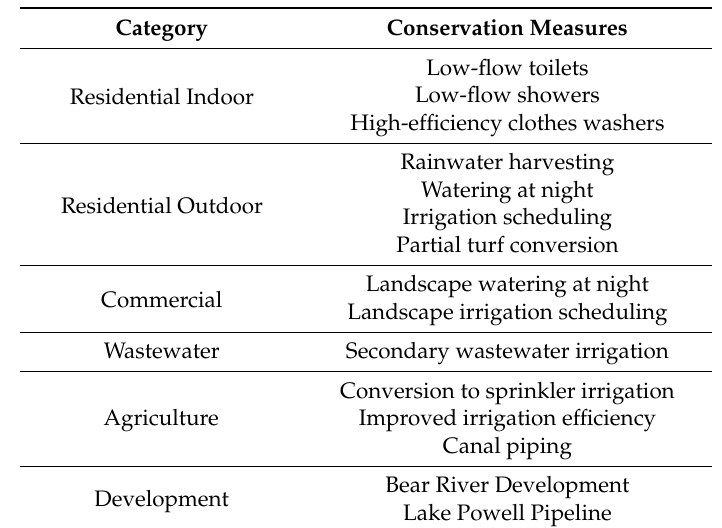
Table 1. Conservation measures by